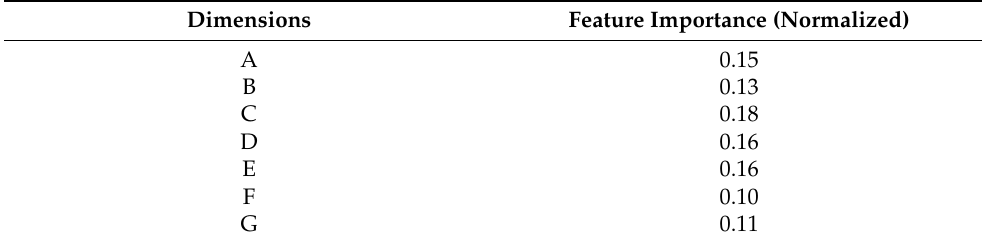
Table 2. Features importance (normalized) calculated based on Gini-impurity.